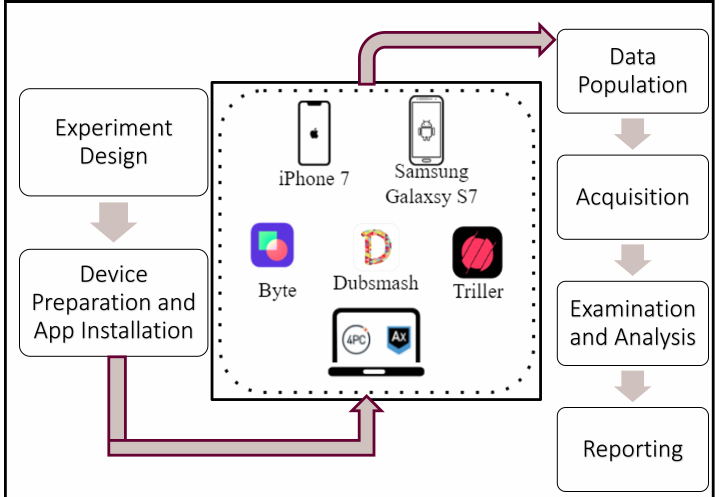
Figure 1. Methodology used in this